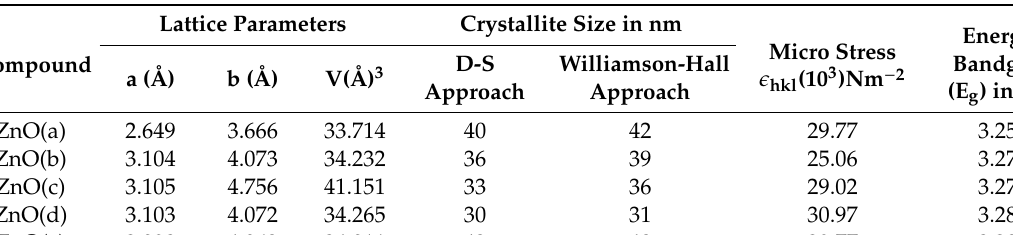
Table 1. Lattice parameters, crystallite sizes, micro stress and energy band gap values of ZnO prepared by various C. verum concentrations.